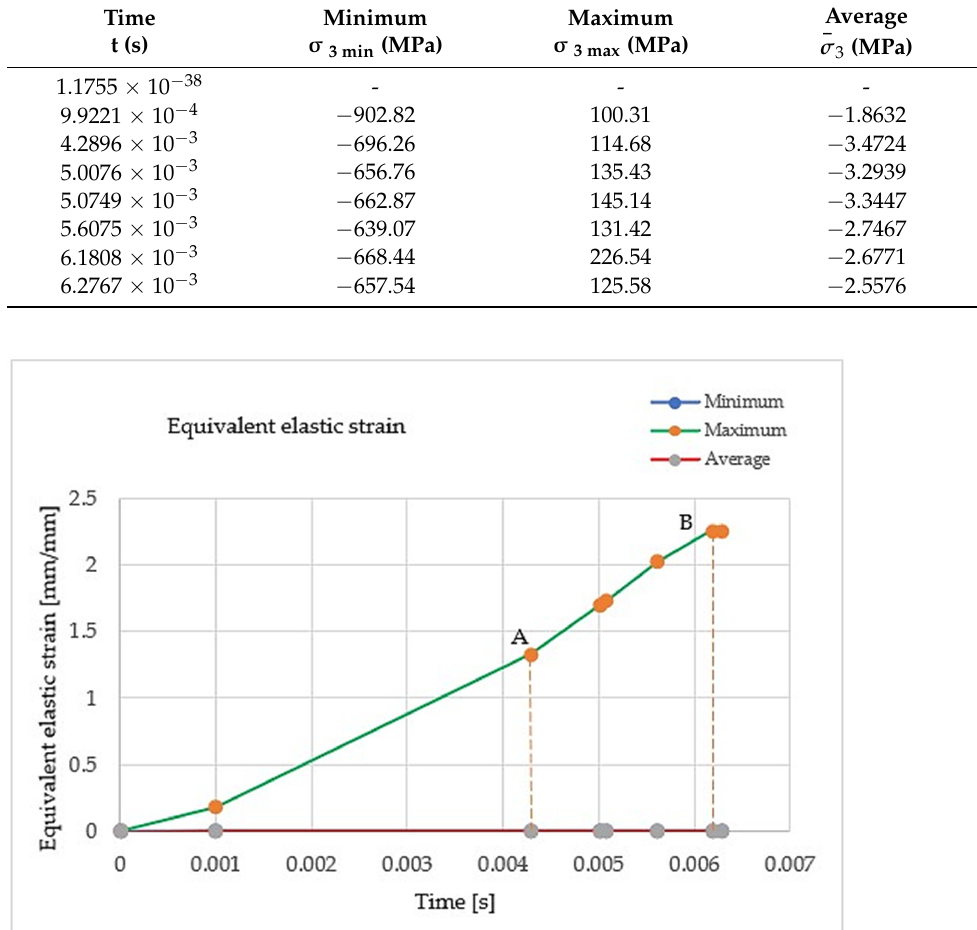
Table 9. Minimum principal stress.